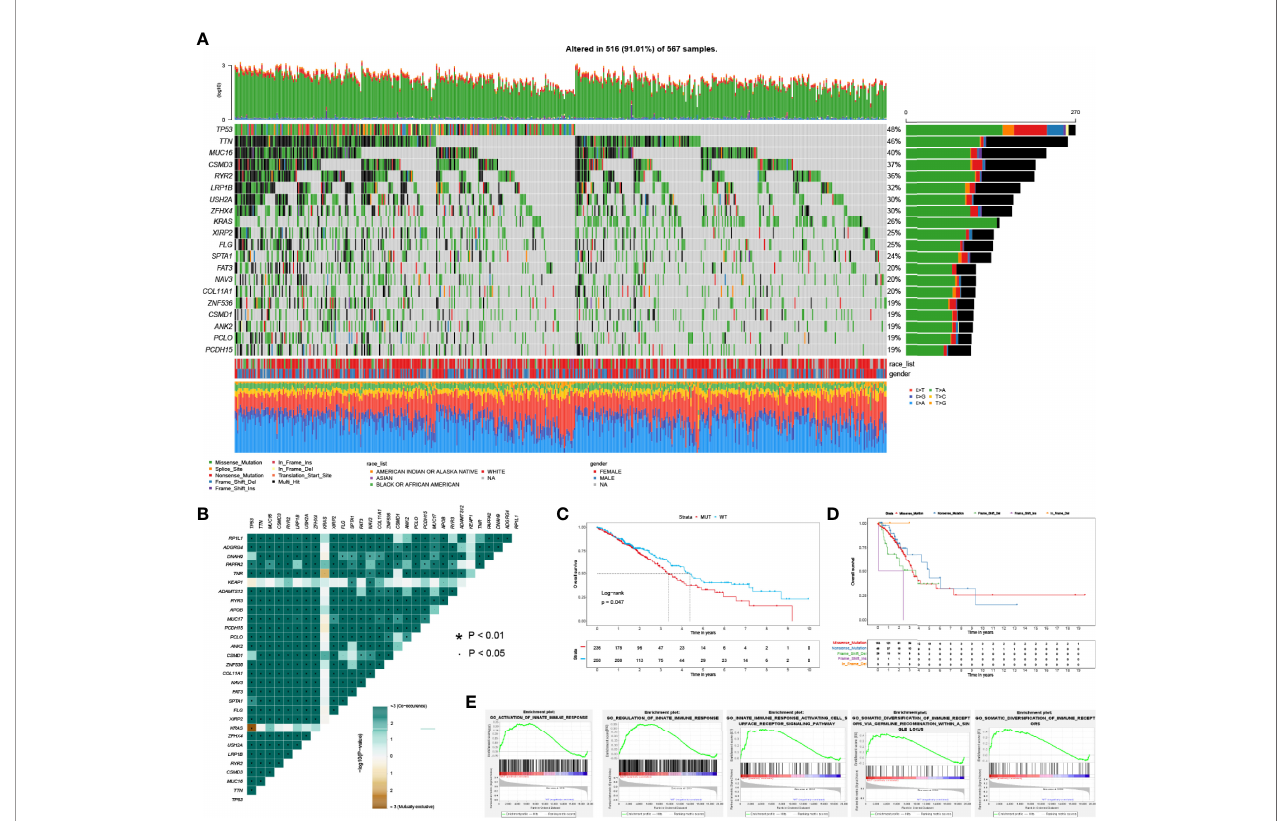
FIGURE 1 | The spectrum of mutated genes and enrichment analysis based on TP53 status in LUAD patients. (A) Frequently mutated genes of LUAD patient in TCGA. (B) Co-occurrence and mutually exclusive analysis of mutated genes in LUAD. (C) Overall survival between TP53 mutant and wild type groups. (D) Overall survival strati fi ed by different mutation types of TP53. (E) Signi fi cantly enriched biological processes between TP53 mutant and wild type